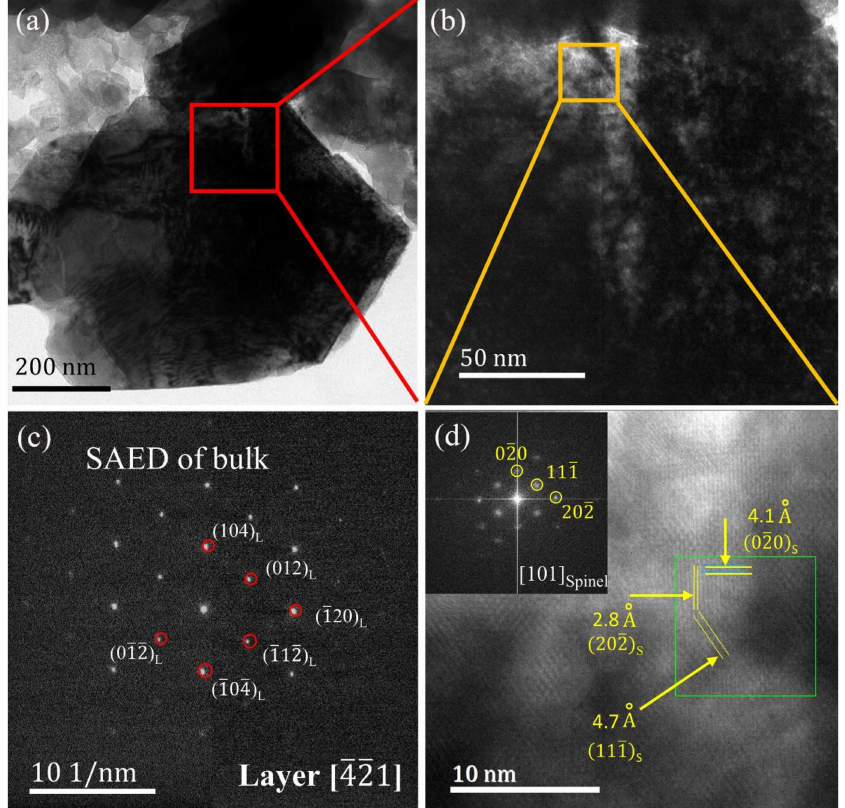
Figure 5. ( a ) The TEM image of Li[Li 0.2 Ni 0.13 Mn 0.54 Co 0.13 ]O 2 after 10 cycles between 2 and 4.8 V at 0.1 C rate. ( b ) The higher magnification image of the red square area of panel ( a ). ( c ) Selected area electron diffraction (SAED) pattern of the particle bulk in panel ( a ). ( d ) The HR-TEM image and fast Fourier transform (FFT) pattern (inset) of the orange square area of panel ( b